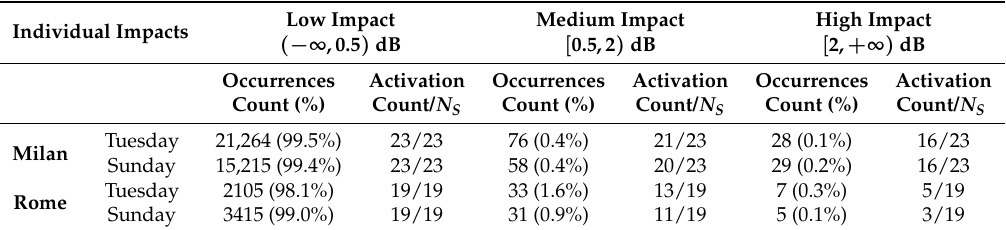
Table 3. Number of occurrences and sensor activation ratios per sensor for low, medium and high individual impact